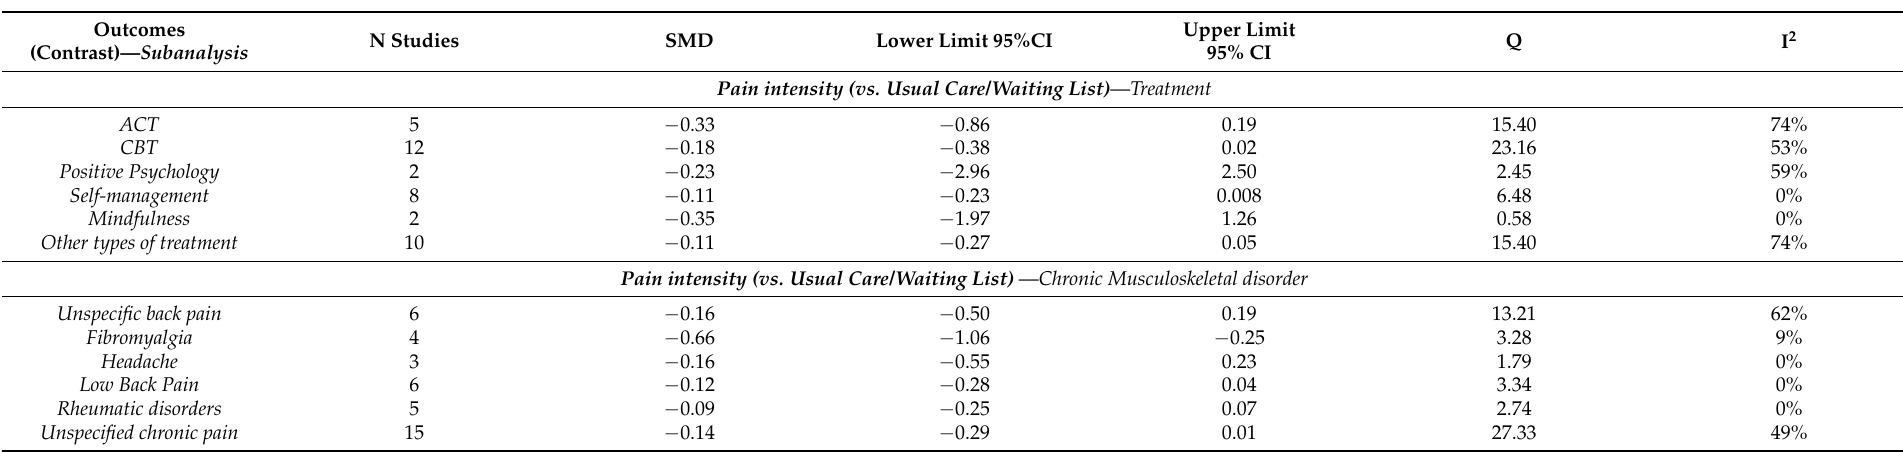
Table 3. Subgroup analyses of the pain intensity, pain interference and self-efficacy